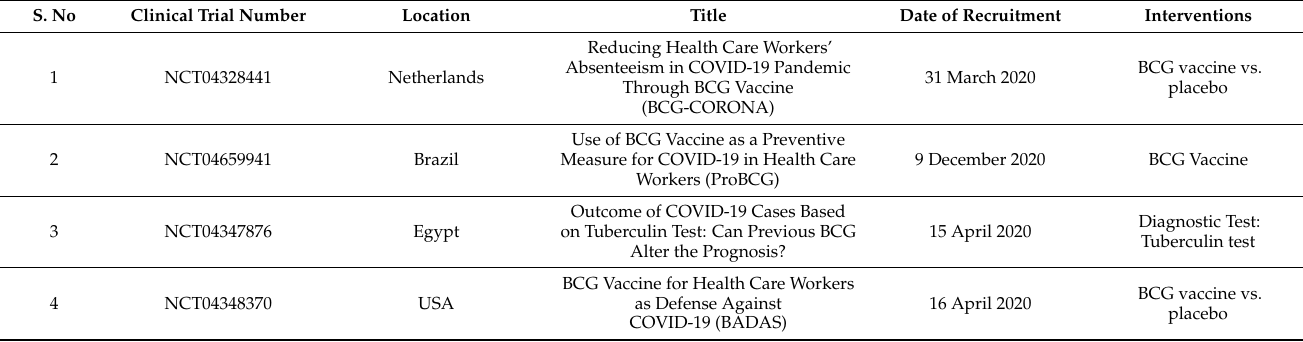
Figure 4 . Triggering trained immunity to enhance the immune response. Innate memory can be created by training IICs with vaccines or immunomodulators. The trained cells revert faster during reinfection with the same or unrelated pathogens. In an untrained innate immune cell, low infection Table 2. Clinical trials using BCG vaccine against is easily cleared off through the secretion of pro-inflammatory cytokines and other soluble media-